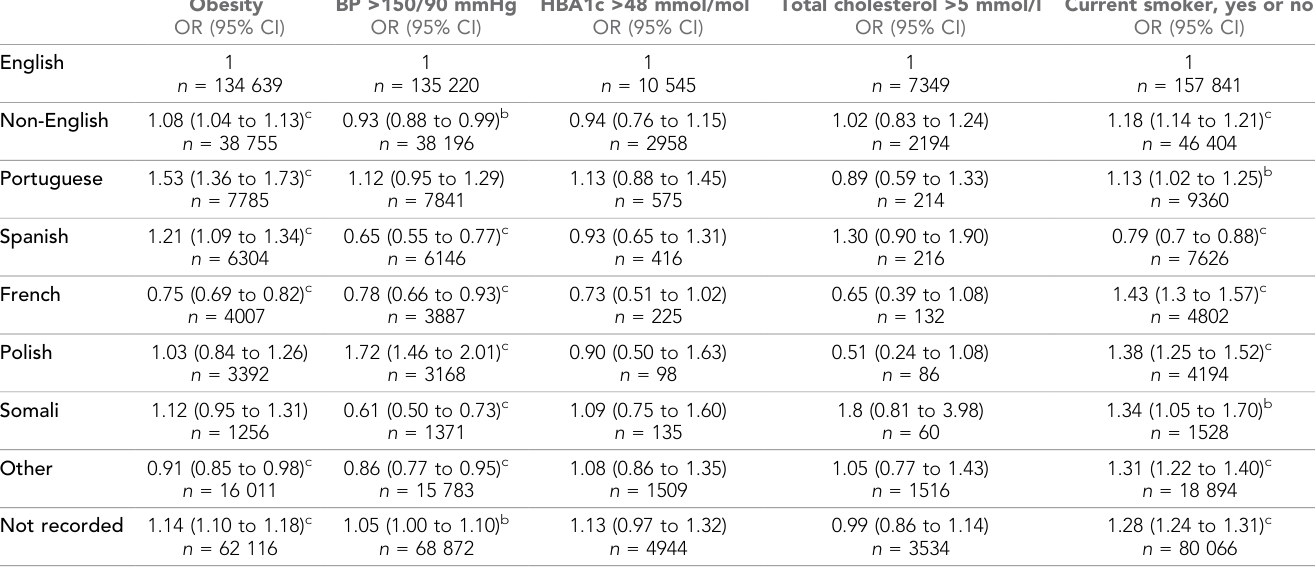
Table 3. Association between cardiovascular risk factors at the most recent measurement and language preferences (adjusted a ORs with 95% CIs). Obesity OR (95%